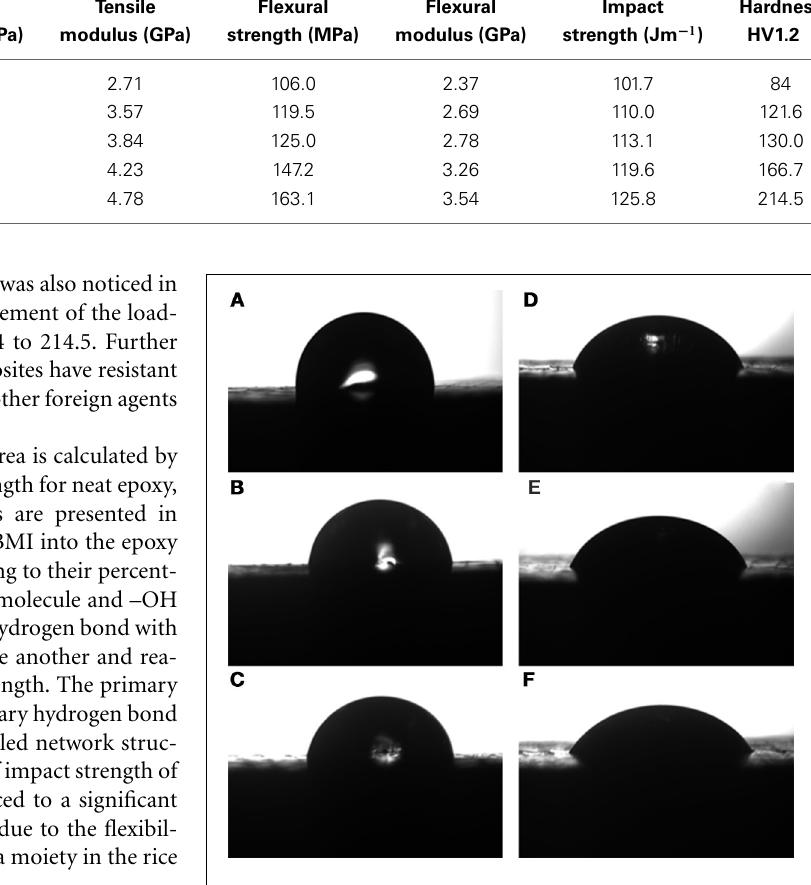
FIGURE 9 | Contact angle of (A-0.5%, B-1.0%, C-1.5% RHA-DGEBA/BMI) for diiodomethane and water (D-0.5%, E-1.0%, F-1.5% RHA-DGEBA/